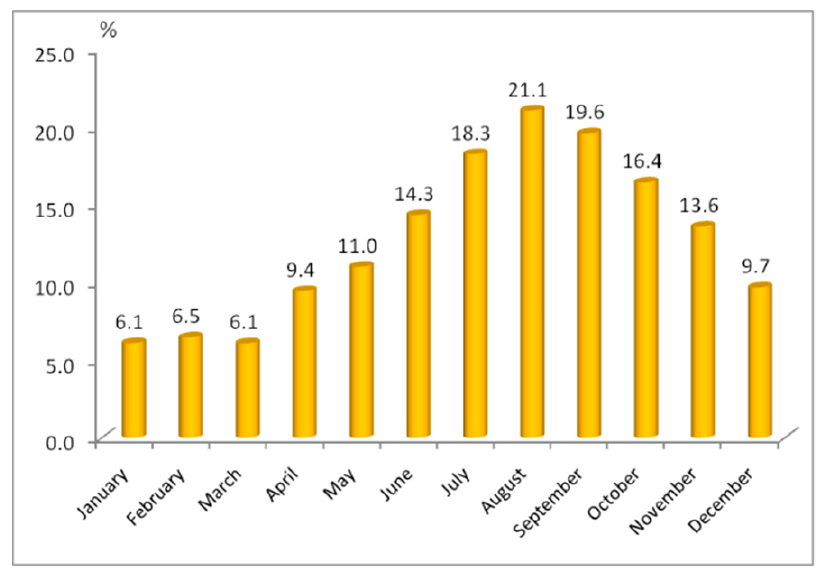
Figure 4. Monthly accommodation occupancy rates (Data source: National Institute of Statistics, TEMPO Online).